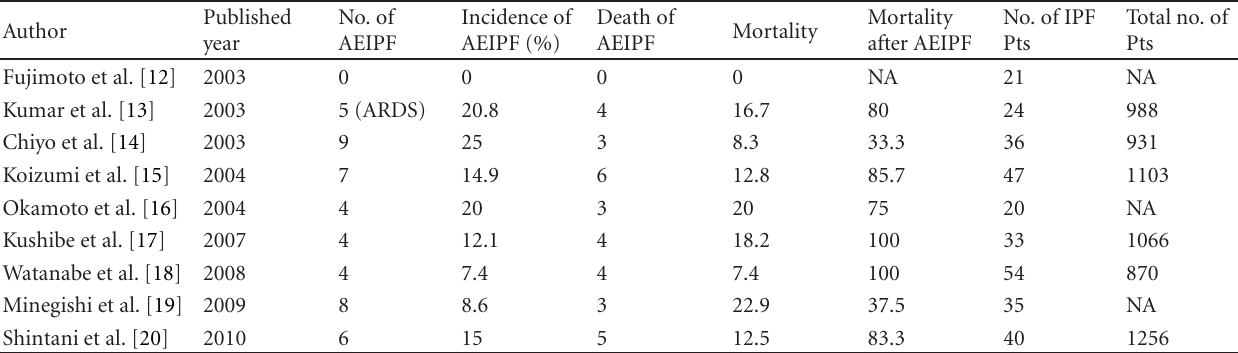
Table 2: The incidence and mortality of postoperative acute exacerbation of